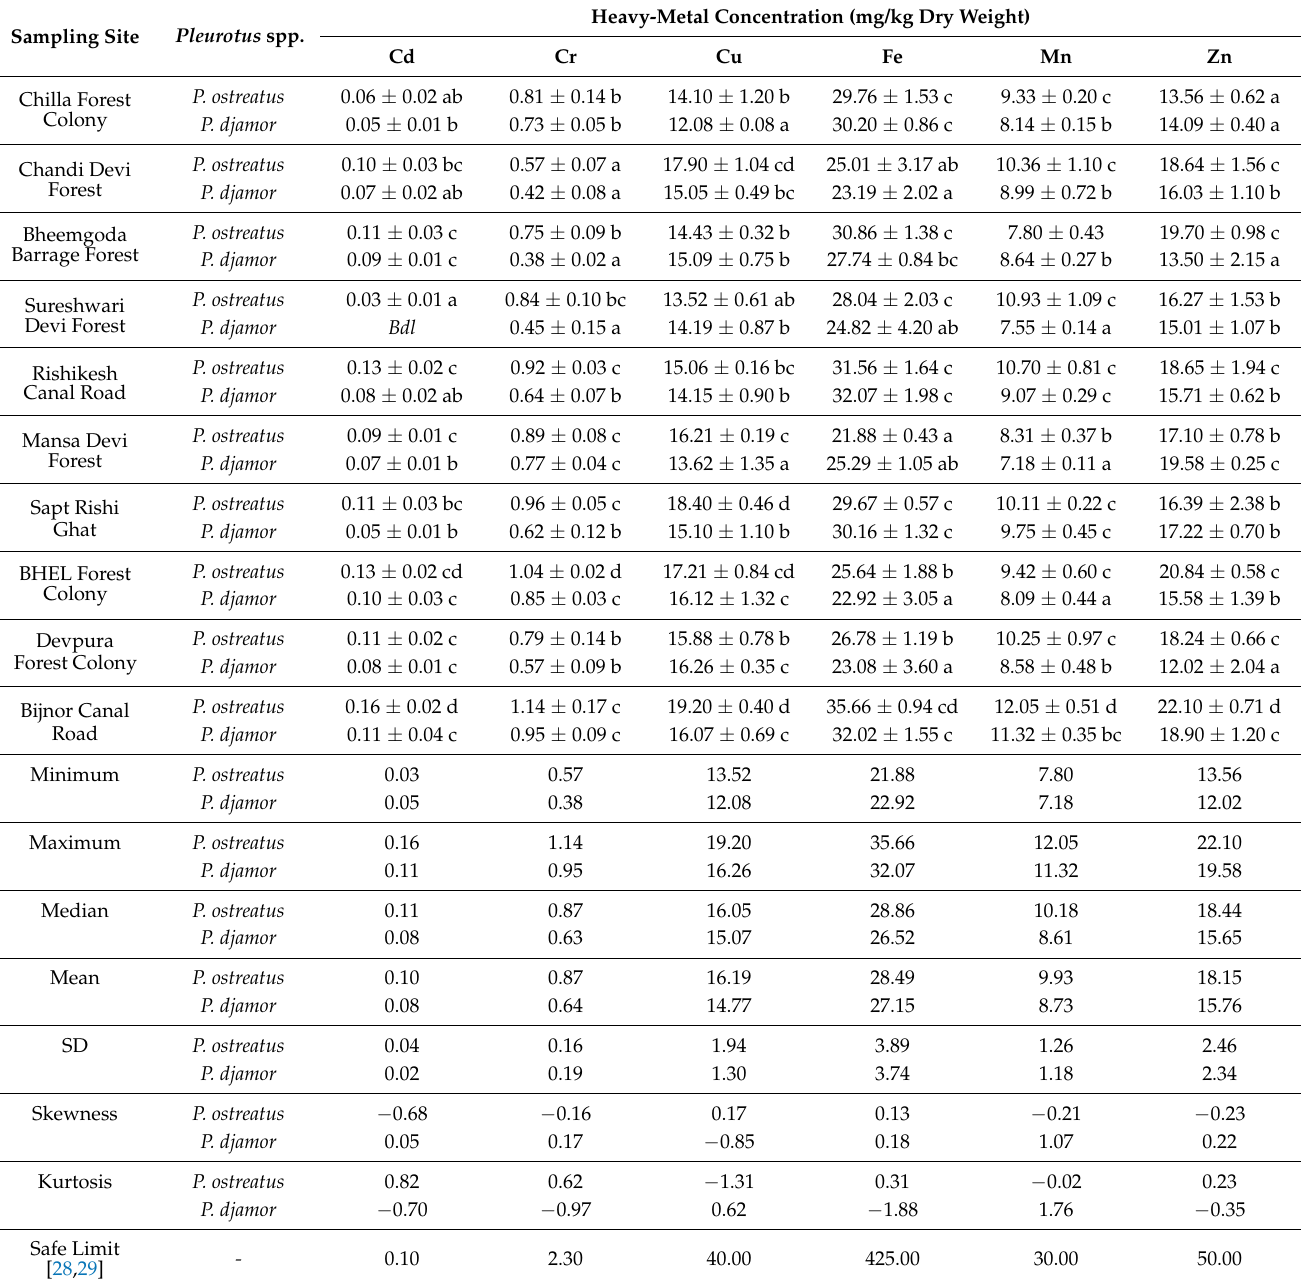
Table 2. Heavy-metal concentration (mean ± SD; n = 2 to 5) in two Pleurotus spp. collected from different locations of Rajaji National Park, Haridwar,